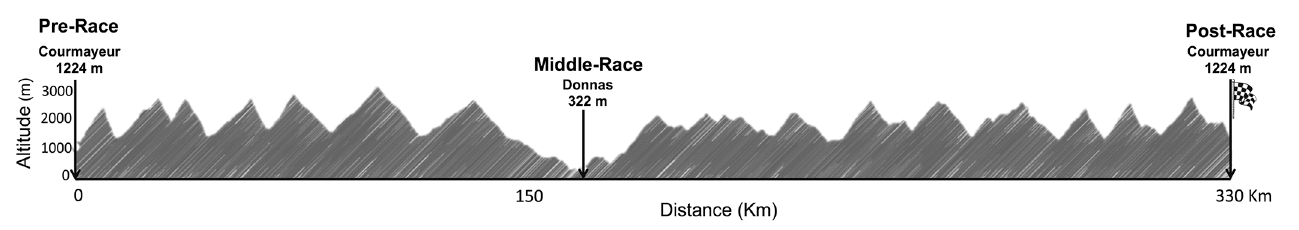
Fig 1. Elevation profile of the race (TDG).